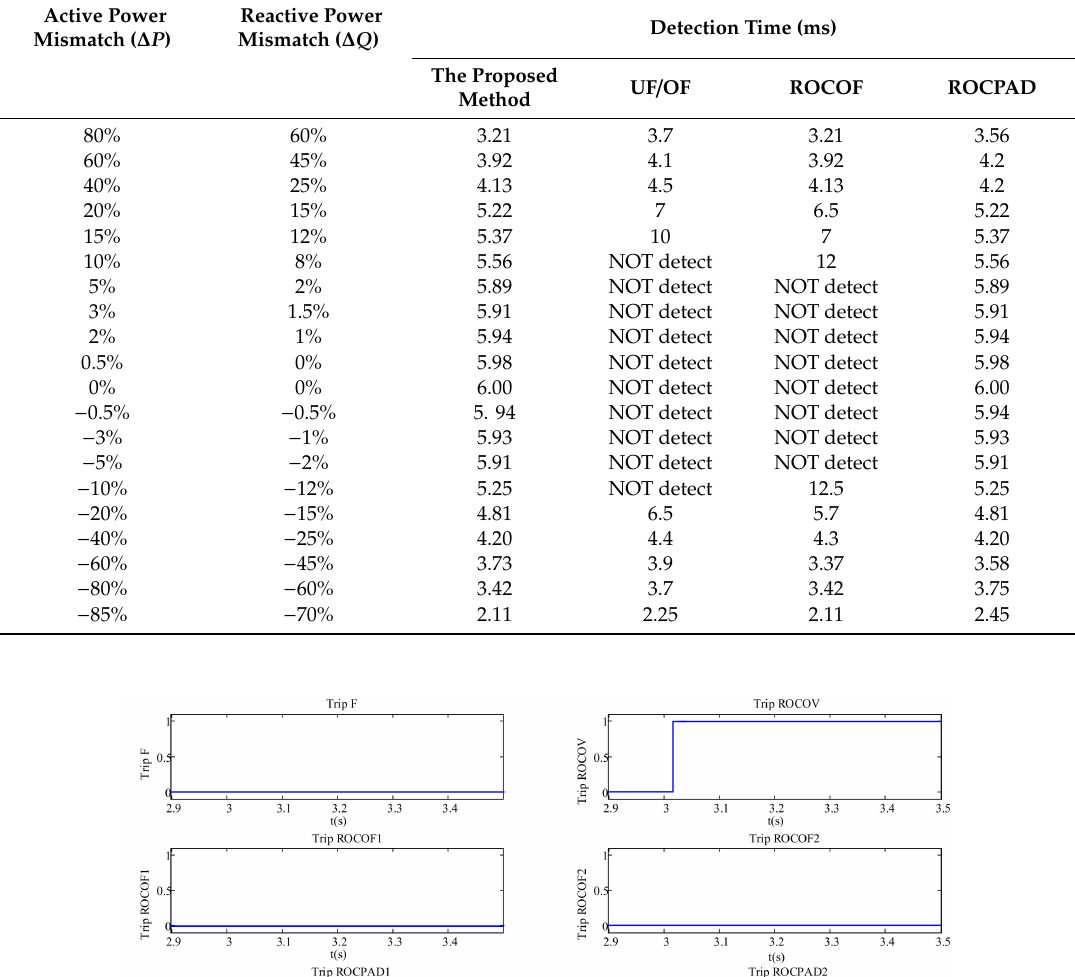
Table 1. Result of islanding detection using the proposed algorithm and classic algorithms for di ff erent active and reactive power mismatches.